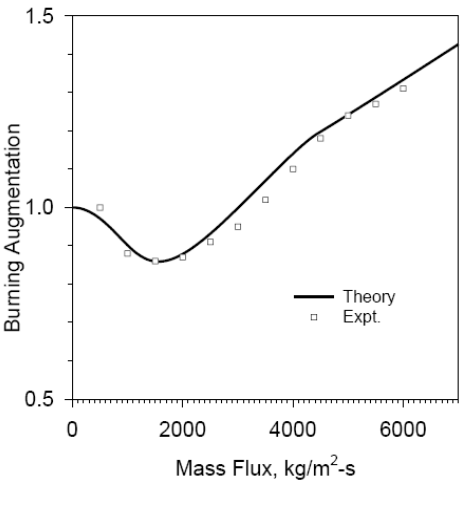
Figure 2. Theoretical and experimental [8,9] data for burning rate augmentation as a function of mass flux ( D u ), double-base solid ∞